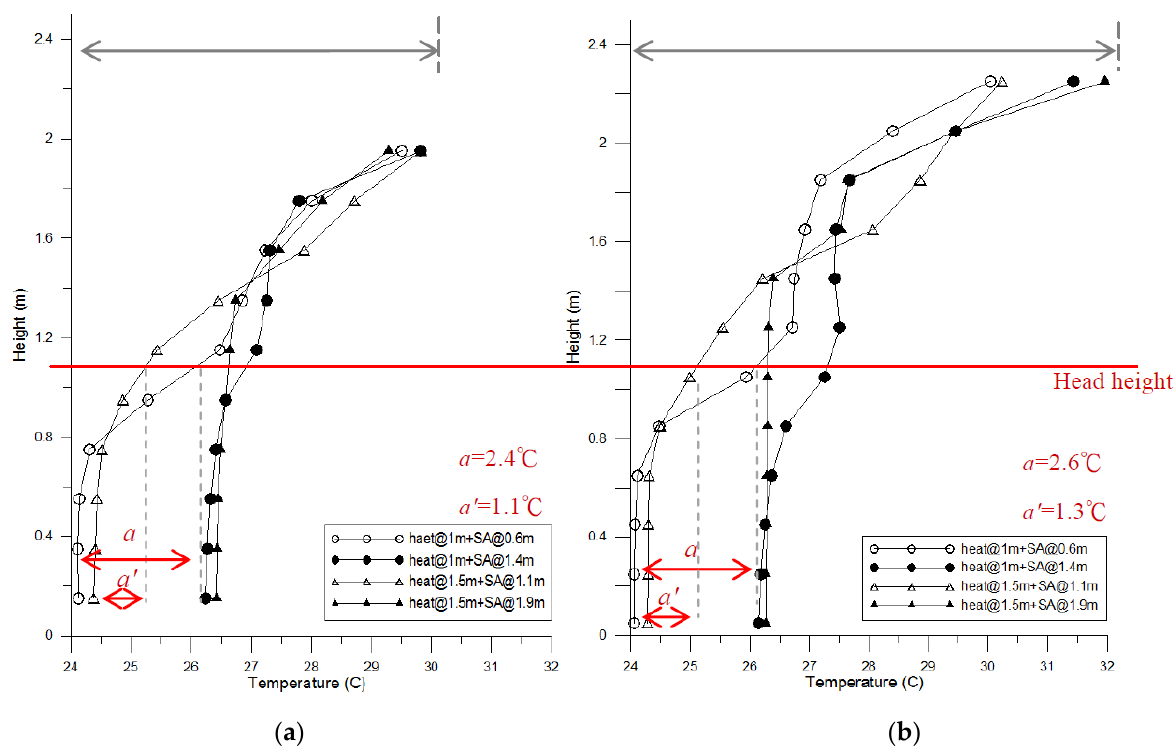
Figure 24. Vertical temperature distribution with various ceiling heights. ( a ) 2.15-m ceiling height. ( b ) 2.45-m ceiling height. Table 13. PMV values with 2.45-M Ceiling Height.